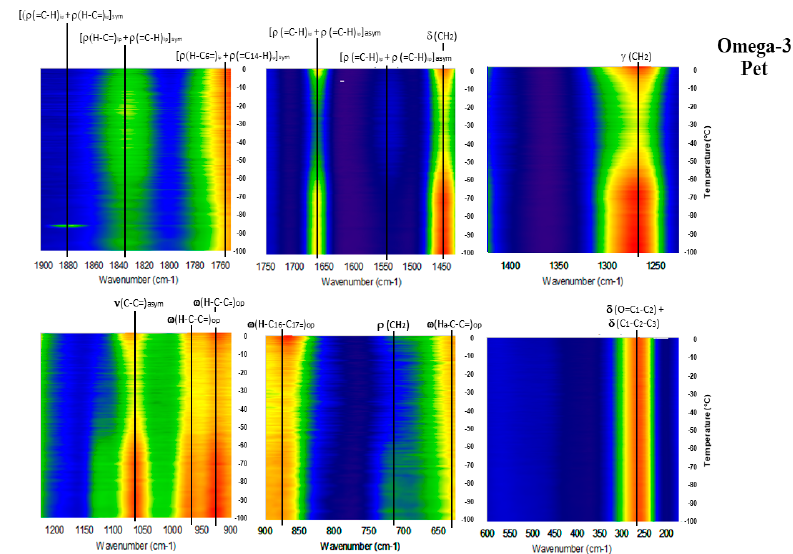
Figure 7. GTRS contour plot, Anchovy and sardine oil (O3P). Note, major Raman mode intensity changes and discontinuities that correlate with heat flow data in Figure changes and discontinuities that correlate with heat flow data in Figure 5.